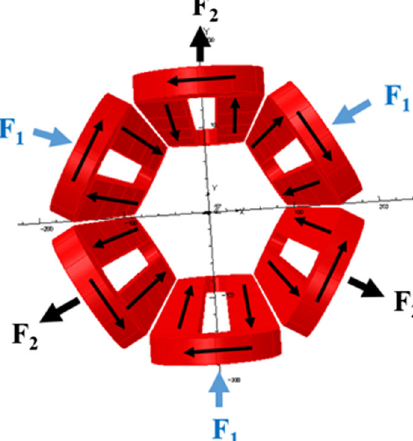
FIG. 6. View of sextupole-coil end in which the adjacent end electric-current flows oppositely. Interaction between the end currents and the axial fields results in strong radially inward force F1 and outward force